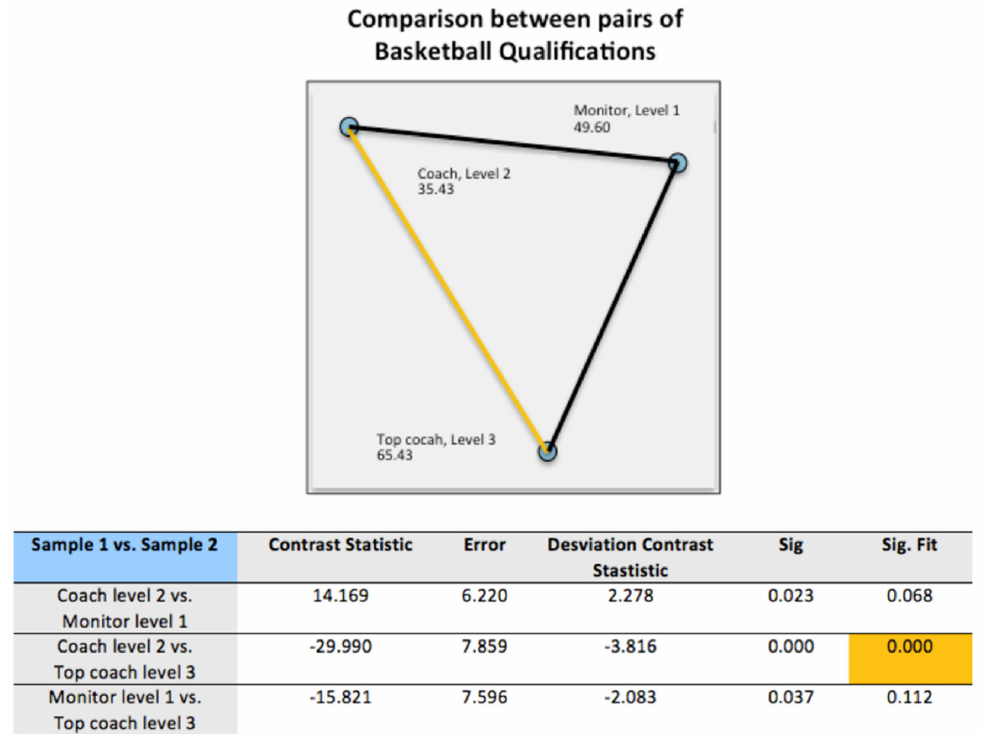
Figure A9. Social support and leadership quality as a function of the basketball